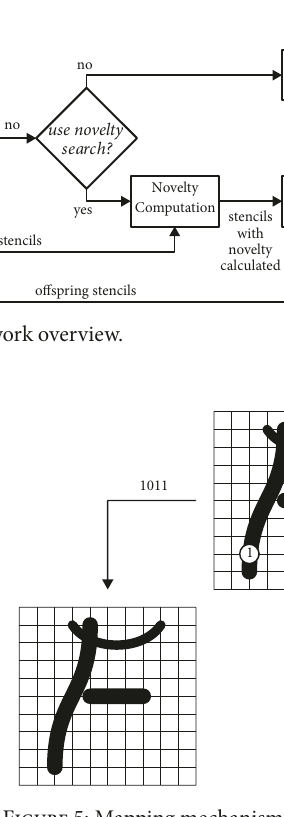
Figure 4: Line encoding. Figure 5: Mapping mechanism expressing the genotype of a stencil (top) into two glyphs (bottom). Binary masks are used to indicate which lines of the stencil should be used to draw the